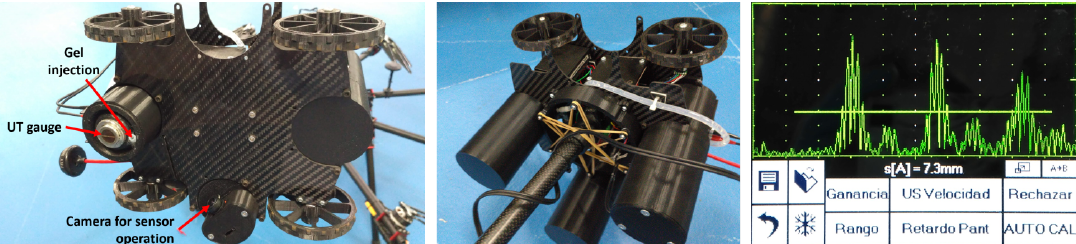
Figure 5. ( left ) and ( center ) Developed robotic end-effector validated in the field experiments equipped with four independently controlled wheels, a UT gauge, a gel injection device and a small camera for sensor-surface contact monitoring. ( right ) Screenshot of the UT sensor interface showing measurements taken during contact with a surface of 7.3 mm of